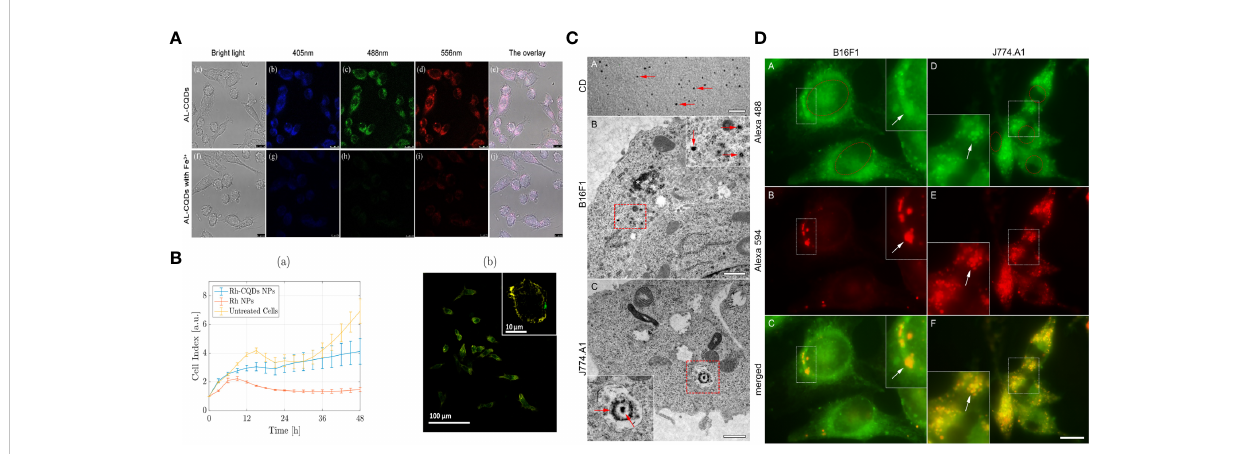
FIGURE 1 Bioimaging of macrophages with various CDs : (A) Fluorescence images indicated AL-CQDs could detect iron ions of RAW 264.7 cells. (B) The RTCA assay demonstrated that Rh-CQDs NPs can enable multimodal imaging in the RAW 264.7 cell line. (C, D) Transmission electron microscopy and Fluorescence microscopy analysis shows that C-dots can be stably imaged in B16F1 and J774.A1